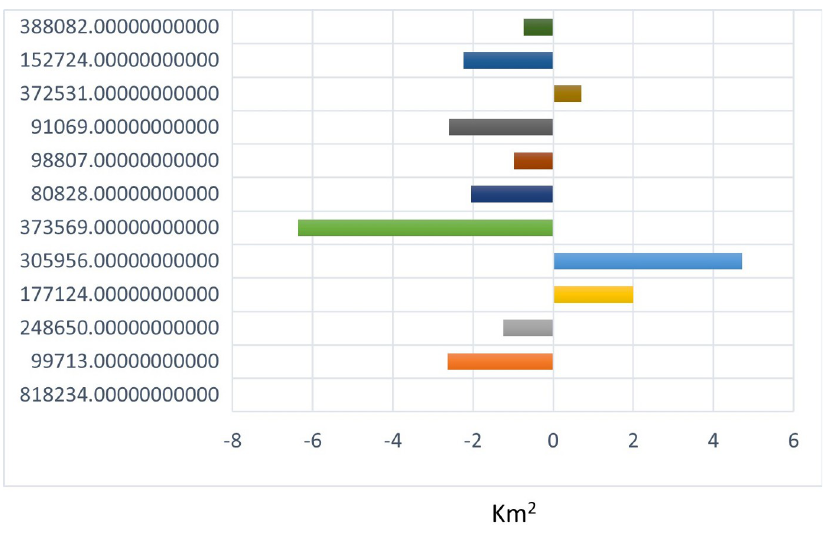
Fig 7. Species contributions to change in Sporobolus centrifugus